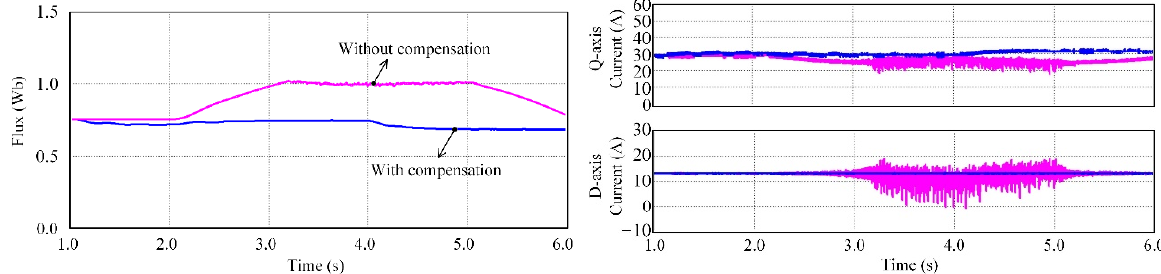
Figure 9. Rotor flux, d-axis, and q-axis current comparative waveforms at 1200 rpm with a 60 Nm load.